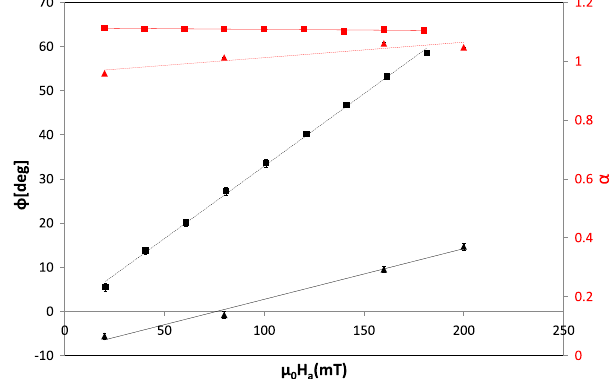
above a FIG. 6. Fit parameter f 0 as a function of applied field for a coin sample in transverse geometry (LAMPF). Fixing α from the normal state calibration yields a smother curve, while the phase correction eliminates the effect of reduced initial polarization due to spin rotation outside of the